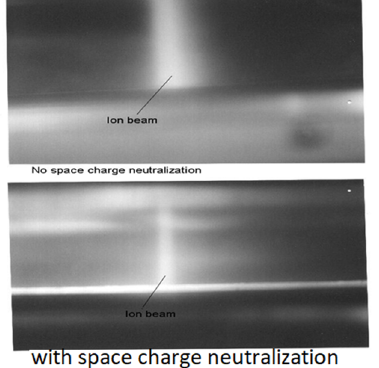
Figure 6. ( a ) Oscillogram showing the increase of beam intensity after the analyzer following injection of electronegative gas; the beam was of 11 B + ions with energy 3 keV and BF 3 neutralizing gas with flux up to 4.6 sccm was injected. ( b ) Mass spectrum of 3 keV B + beam after analyzer magnet for different neutralizing electronegative gas fluxes.